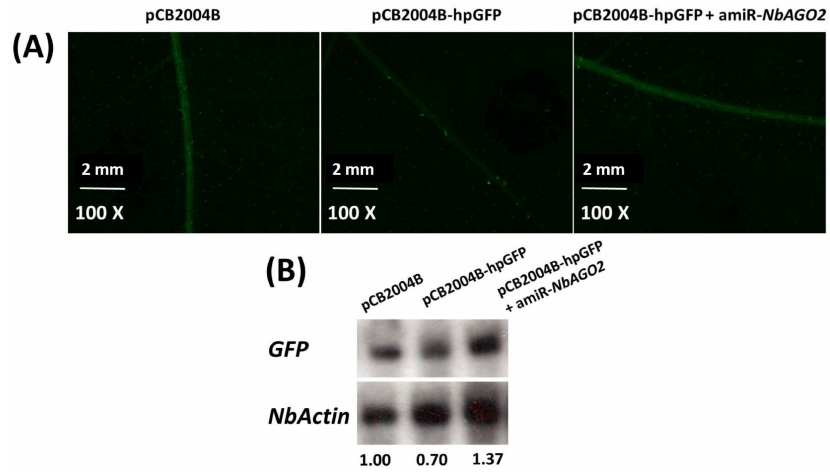
Figure 3. Silencing of NbAGO2 compromised hairpin induced RNAi in N. benthamiana . ( A ) Three-leaf stage GFP16c transgenic plants were inoculated with di ff erent combinations of vector constructs. GFP fluorescence was visualized under Nikon SMZ18 microscope at 3 DPI. ( B ) The infiltrated leaf tissues were harvested, total RNAs were extracted, and GFP mRNA levels were determined by Northern blot experiment. Expression of N. benthamian a β -actin served as internal control. The number below the panel indicates the ratio of the blot band intensity between GFP and NbActin , in which the ratio in first lane was arbitrarily designated as